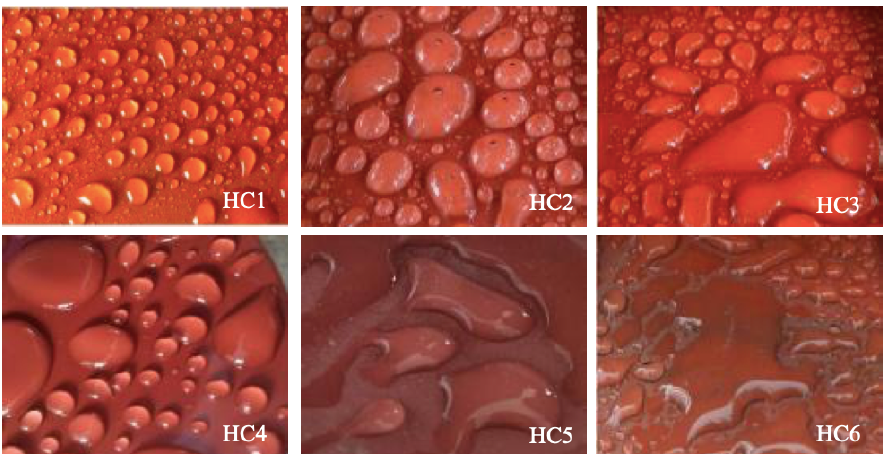
Figure 11. Hydrophobic classes from HC1 (highly hydrophobic) to HC6 (highly hydrophilic)